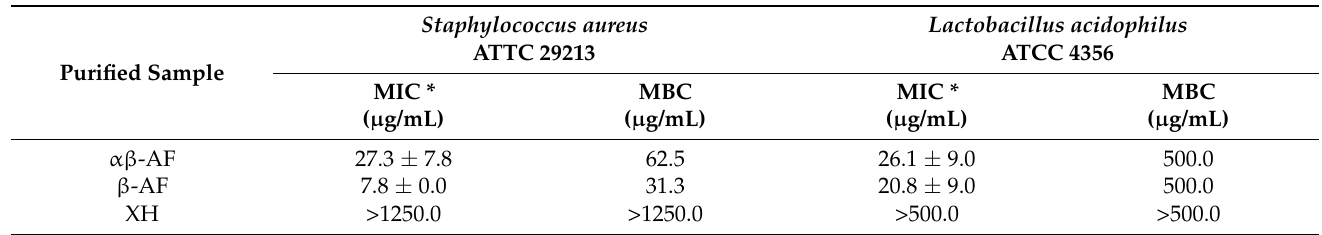
Table 5. The MIC and MBC values of investigated purified samples against Staphylococcus aureus and Lactobacillus acidophilus